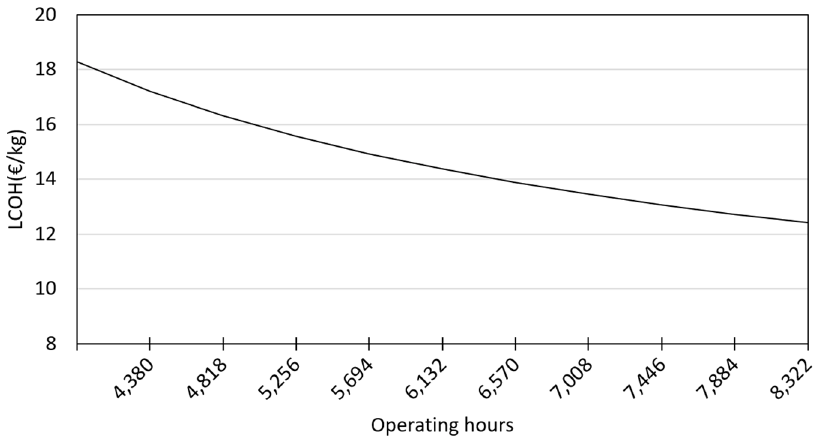
Figure 10. Effects on the LCOH with different operating hours.